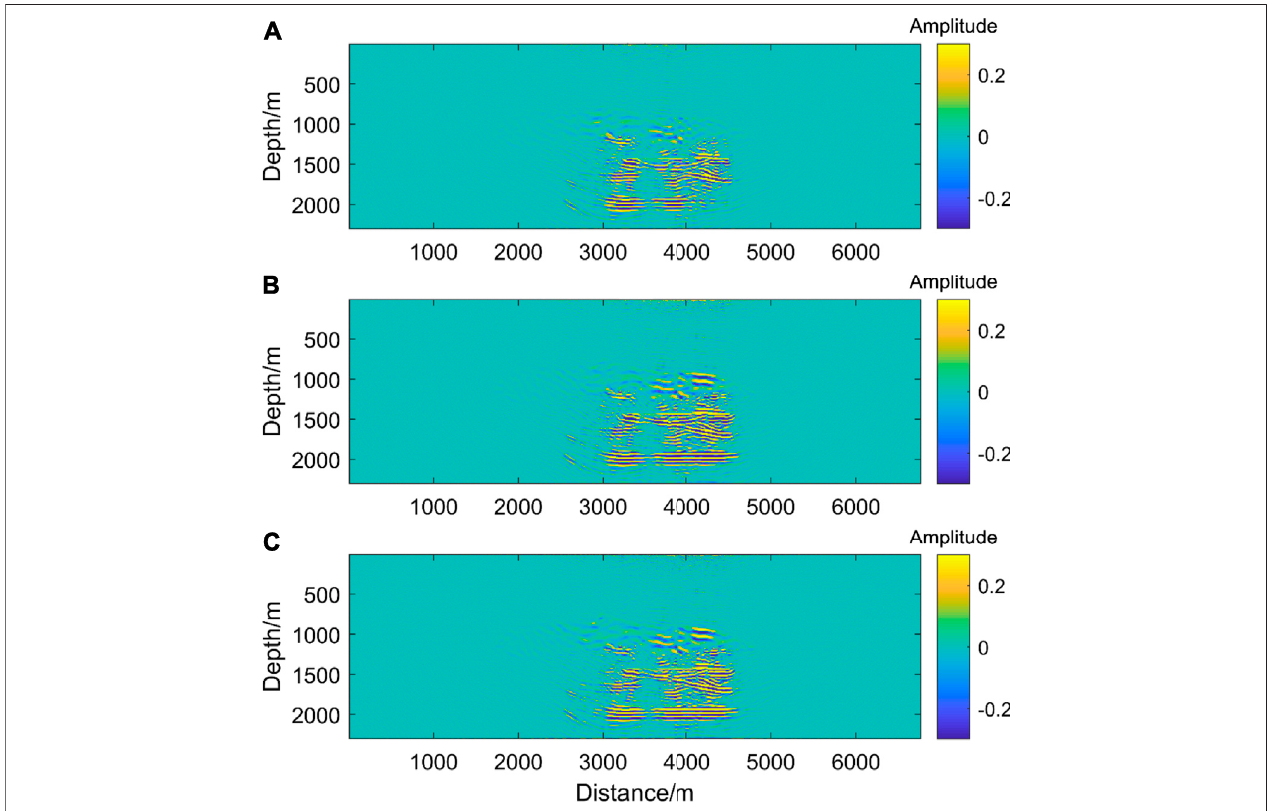
FIGURE11|(A) istheimage resultfor thetarget areawithshots selected bytheone-way illumination. (B) istheimage result forthetarget areawithshotsselected by the two-way illumination. (C) is the image result for the target area with all shots.